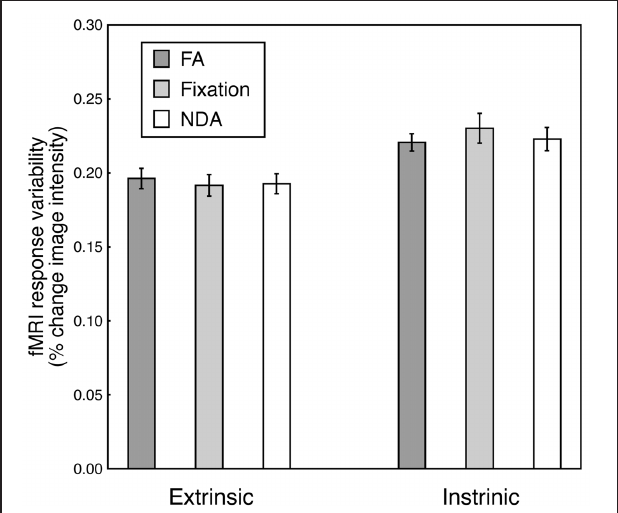
FIGURE 5 | Response modulation. Height of each bar, standard deviation of fMRI response time-series, averaged across ROIs and across participants. Extrinsic, average across all extrinsic system ROIs. Intrinsic, average across all intrinsic system ROIs. FA, focused attention. Fixation, fixation without meditation. NDA, non-dual awareness. Error bars, SEM across participants.